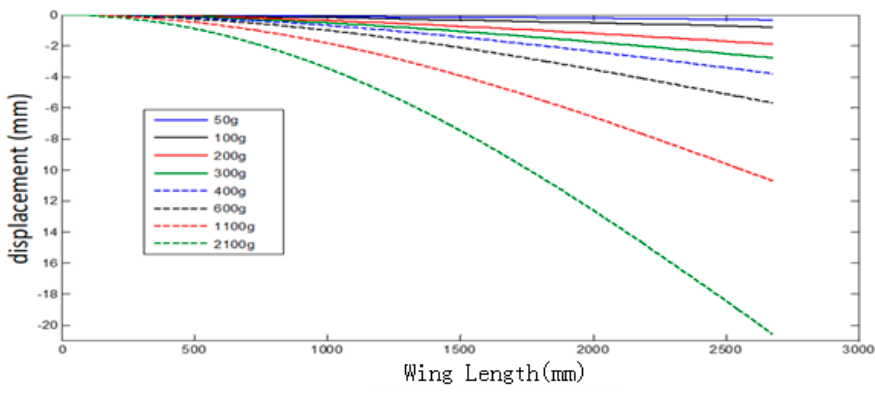
ff erent loading conditions. Figure 15. Under different loading conditions. Figure 15. Under di Figure 15. Under different loading conditions.